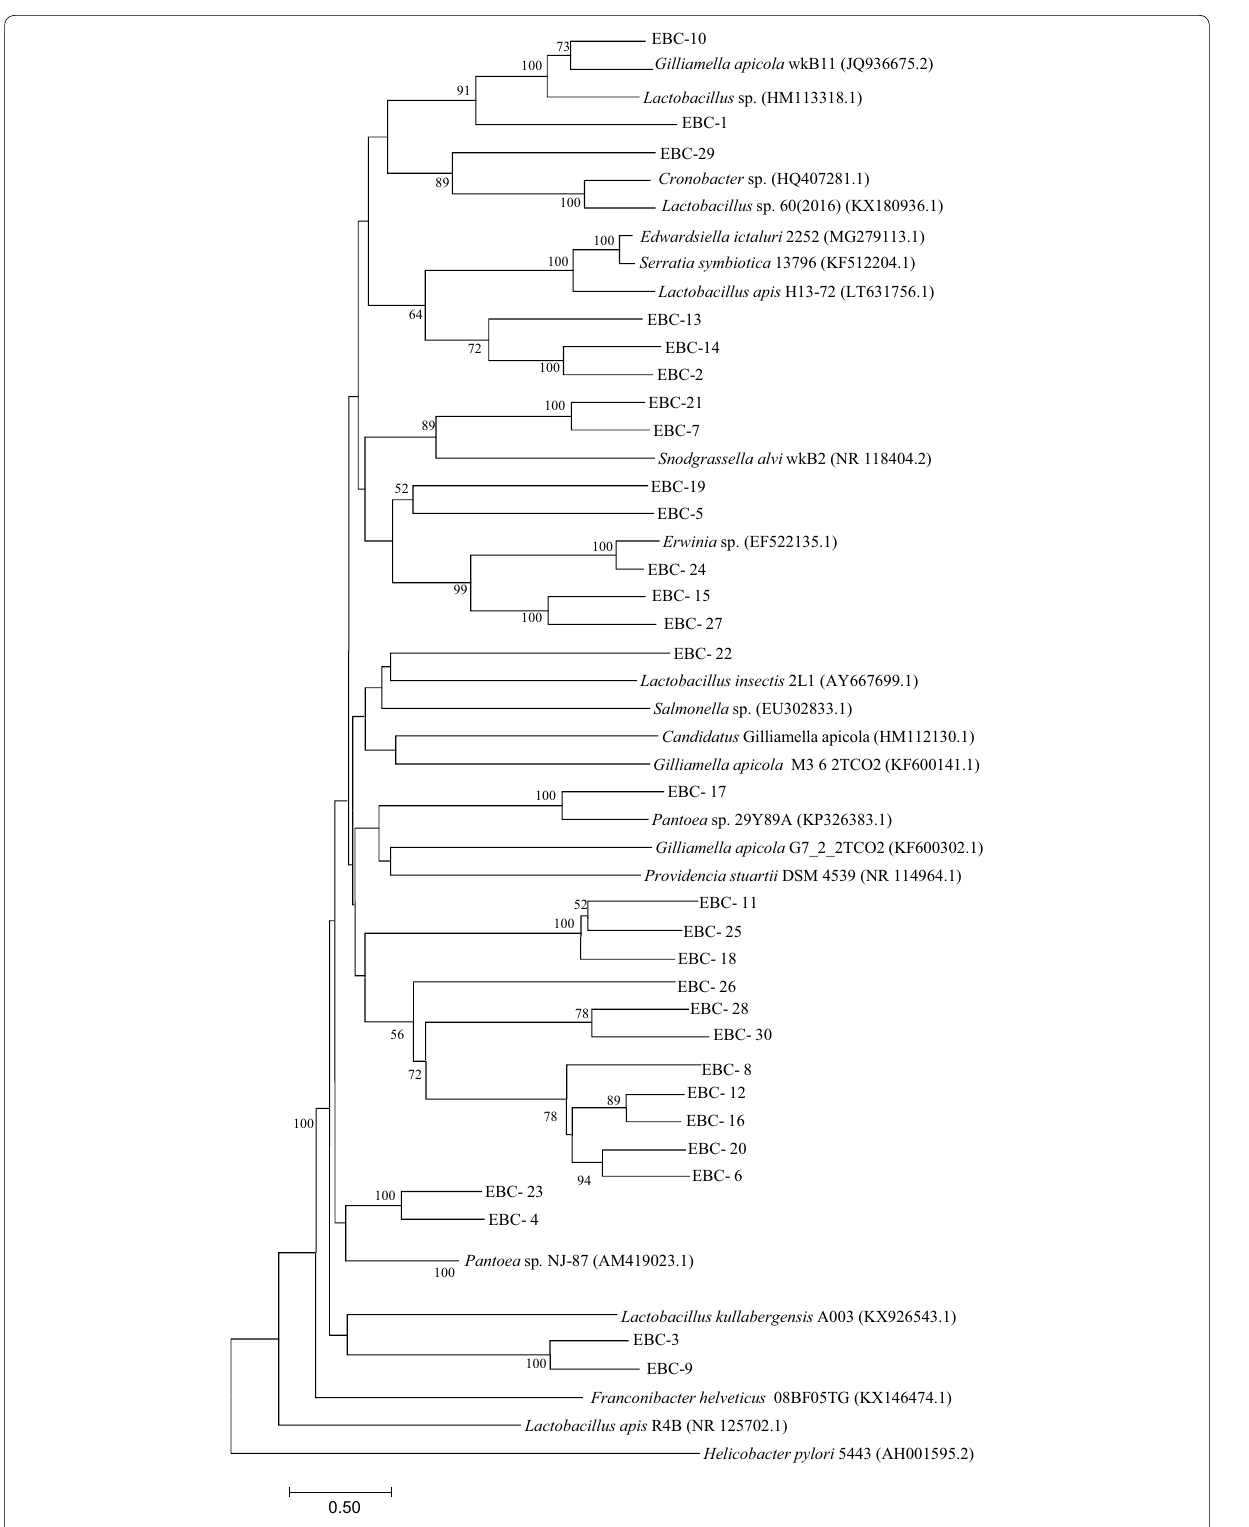
Fig. 3 Phylogenetic tree of the gut microbial clones of the exposed bees. The evolutionary history was inferred using the neighbor‑joining method and the evolutionary distances were computed using the Kimura‑2 parameter. The percentage of replicate trees in which the associated taxa clustered together in the bootstrap test (1000 replicates) is shown next to the